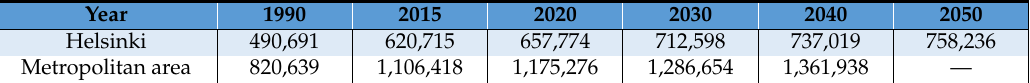
Table 2. Population scenarios and projections for the cities in the Helsinki metropolitan area [28].